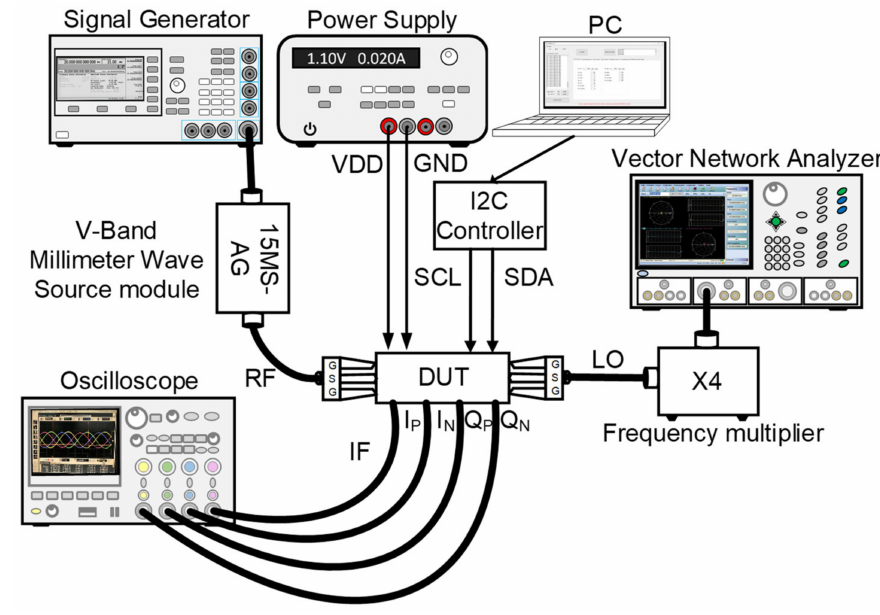
Figure 14. I/Q waveform measurement setup of 60 GHz CMOS I/Q receiver.